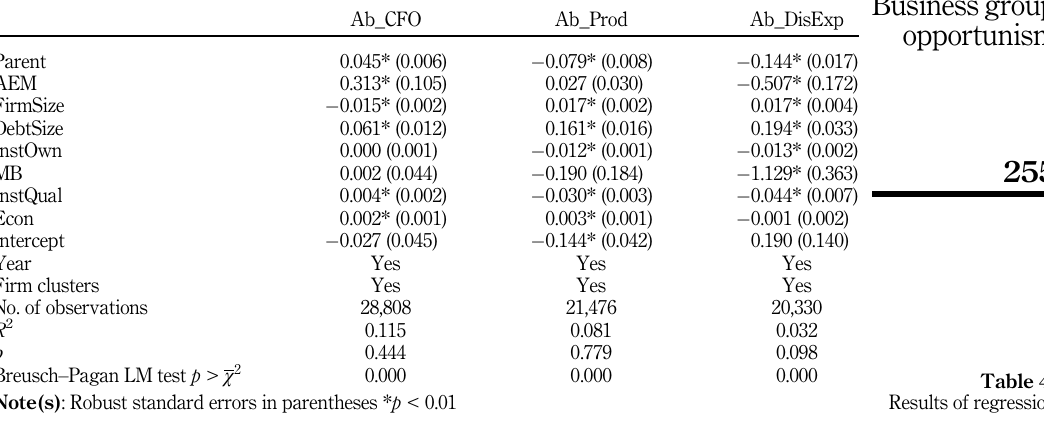
Table 4. Results of